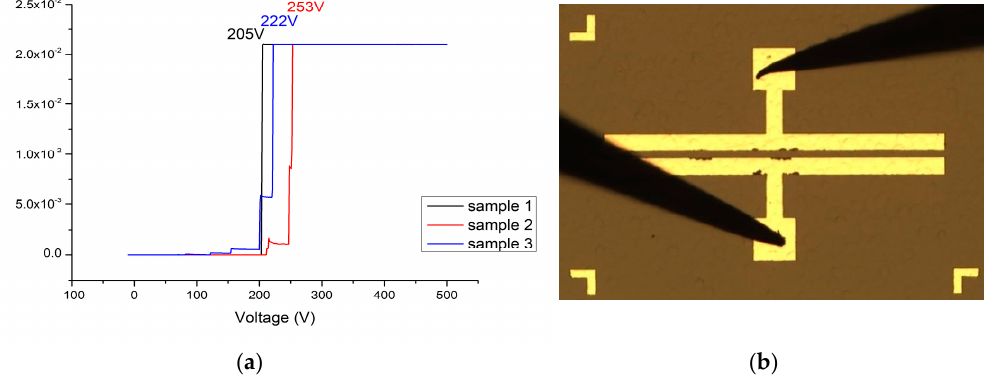
Figure 20. ( a ) I–V measurement results (sample 1 in black, sample 2 in red, and sample 3 in blue) and ( b ) breakdown image of the original MSM varactor.